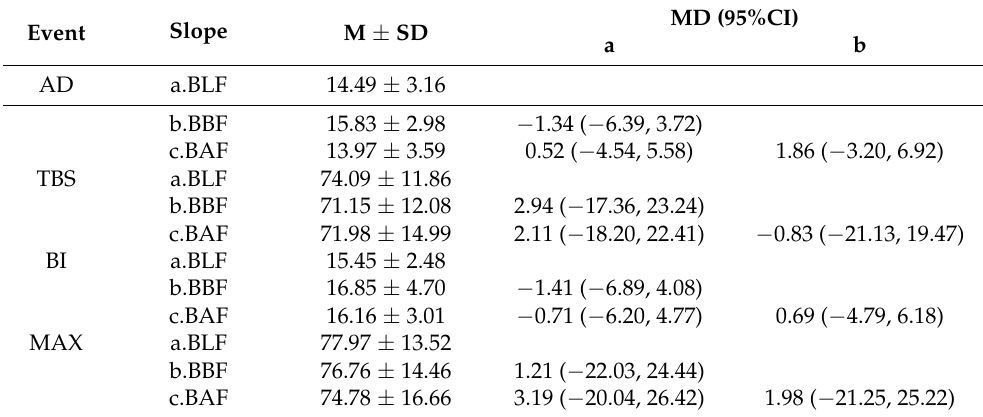
Table 6. X-factor angle results for the BLF, BBF, and BAF at different events. Event Slope